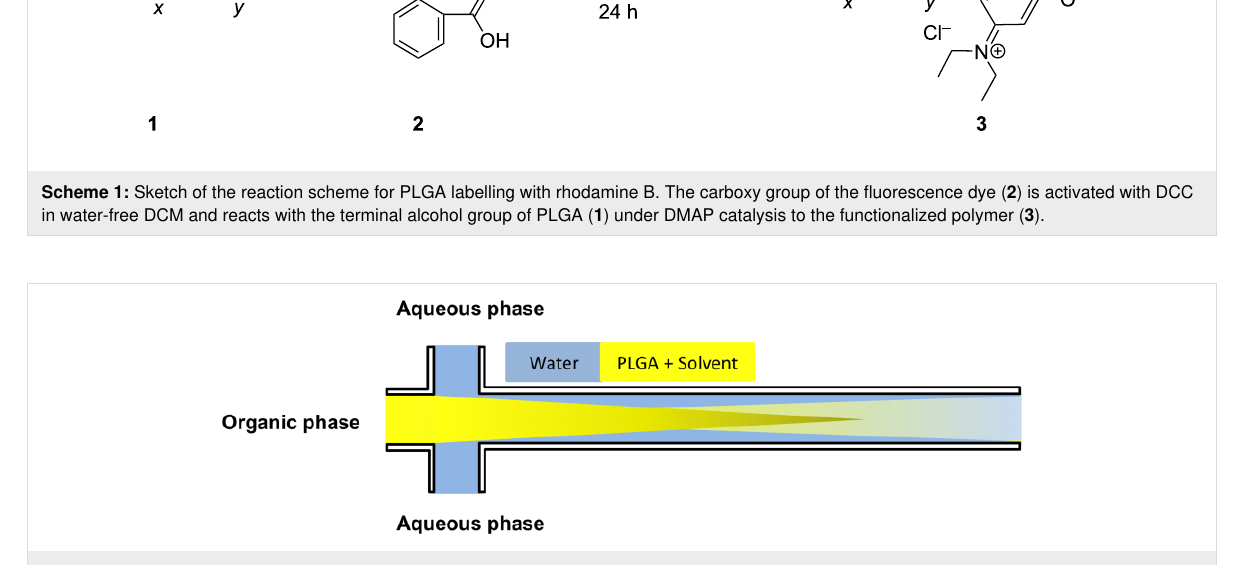
Figure 13: Design and flow pattern of the microfluidic system.